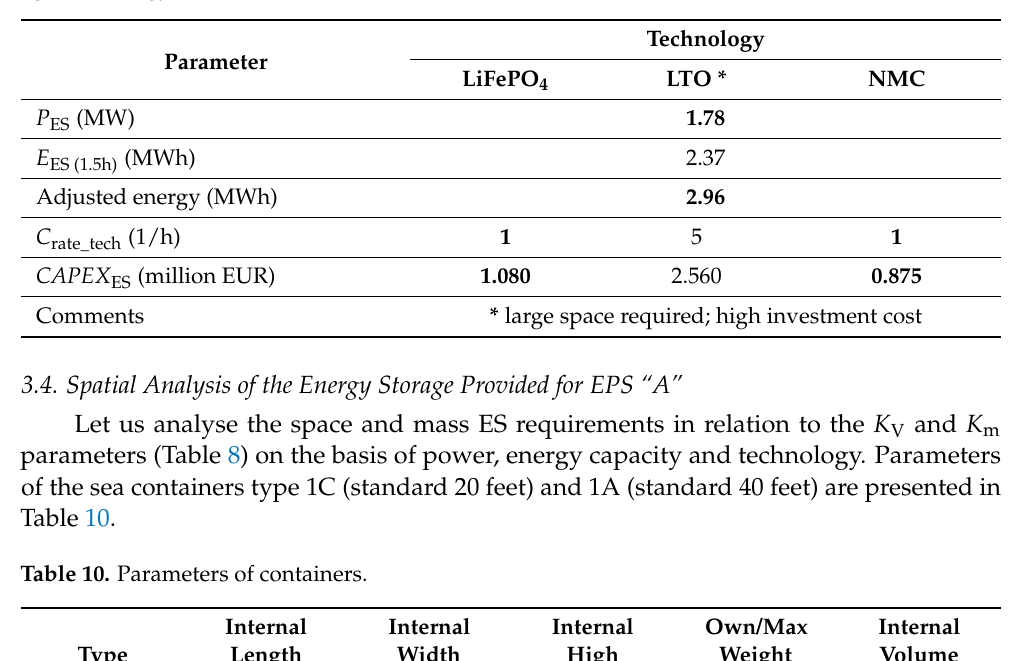
Table 9. Adjusted parameters and estimated ES investment cost CAPEX ES depending on the stor- age technology.